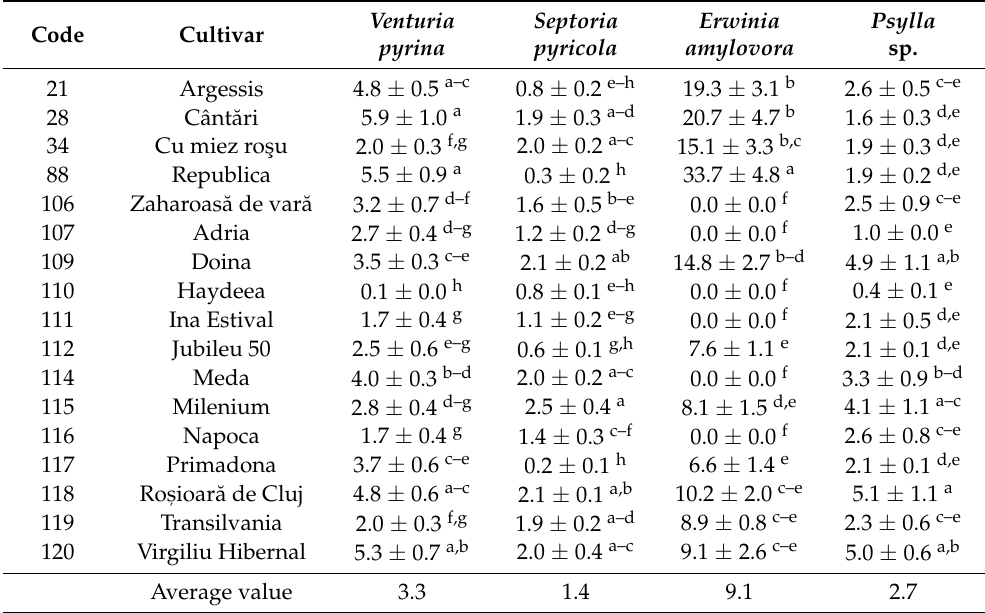
Table 2. Responses to the principal diseases and pests of 17 Romanian pear cultivars (as degree of attack, DA %) 1